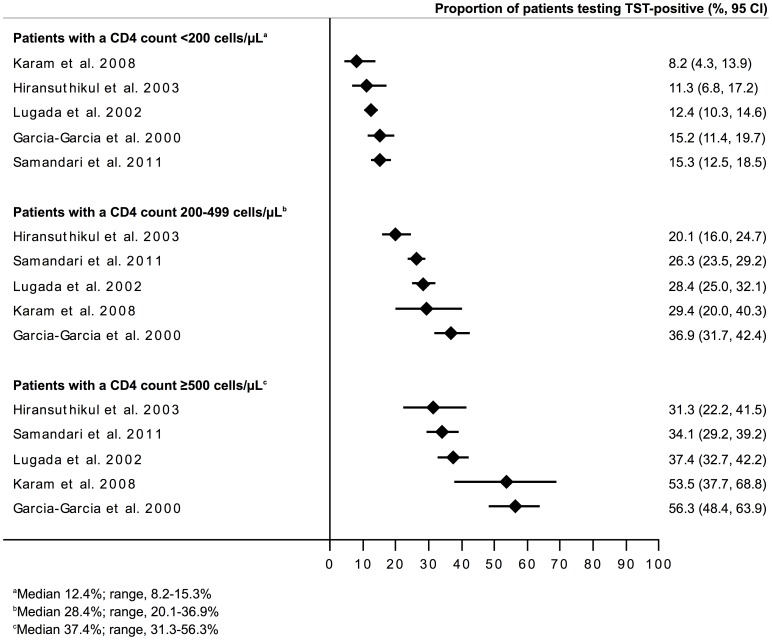
Forest plot showing the proportions (%, 95%CI) of people living with HIV testing TST-positive in studies (n = 5) included in the meta-analysis with data grouped according to CD4 cell count strata (<200, 200–499 and ≥500 cells/µL).The median proportions testing positive in these three groups were 12.4% (range, 8.2–15.3%), 28.4% (range, 20.1–36.9%) and 37.4% (range, 31.3–56.3%). The I2 statistics for these three groups of data were 54.4% (P = 0.067), 84.2% (P<0.001) and 86.8% (P<0.001), respectively.